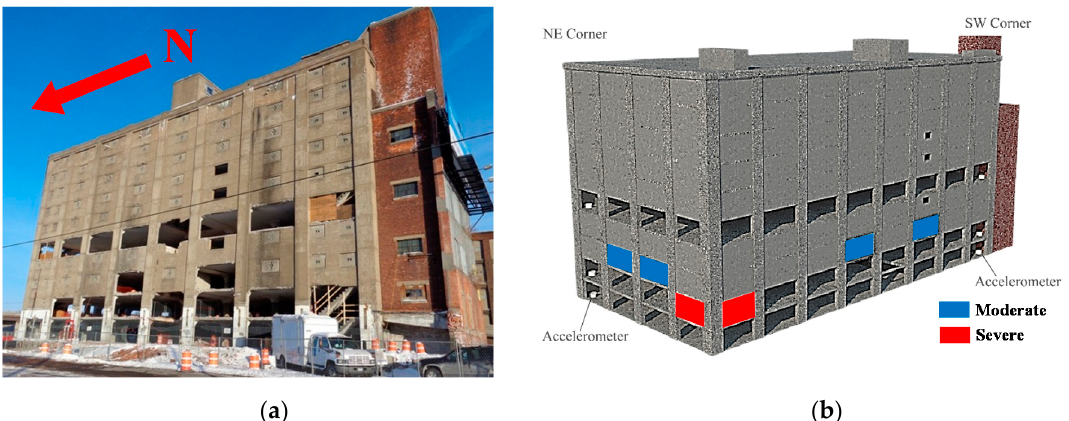
Figure 8. ( a ) South-west view of 10-story building; ( b ) location of removed walls for moderate and severe damage states.